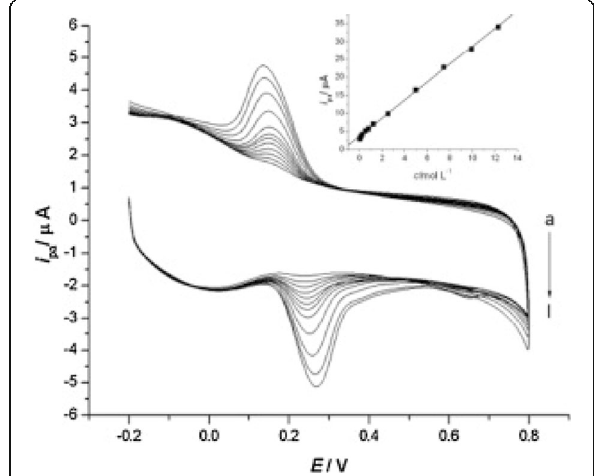
Fig. 6 CVs of DES at the GR/Nano-Au/GCE electrode with different concentrations. Inset is the plot of the oxidation peak current versus concentration of DES. (Reprinted with permission from Reference Ma and Chen 2015). © 2015 Elsevier